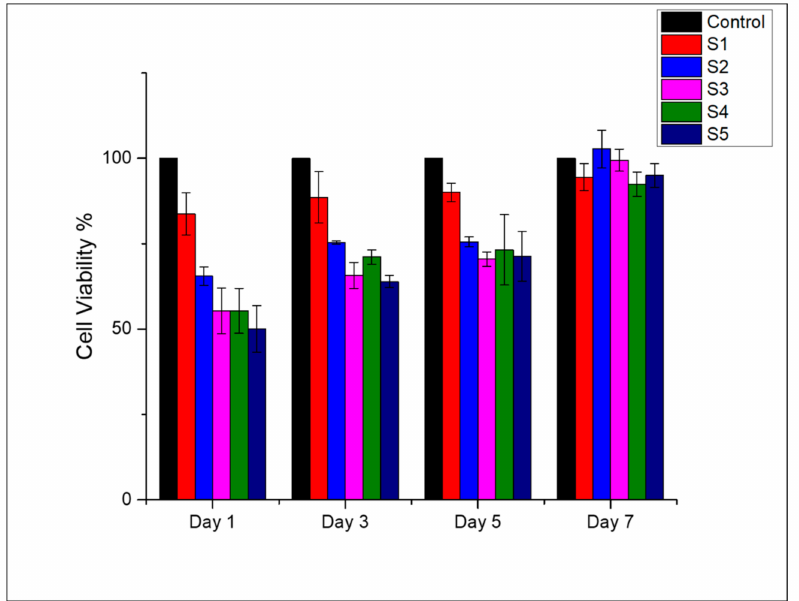
Figure 5. Cell viability of L929 cell line by mitochondrial activity using WST-1 assay, cultured for 1, 3, 5, and 7 days in presence of neat (S1) and DLF loaded PAN nanofibers (S2, S3, S4, and S5). To determine the morphological differences, cell-cell and cell-material interactions were investigated by SEM imagery. The represented micrographs are shown in Figure 6.